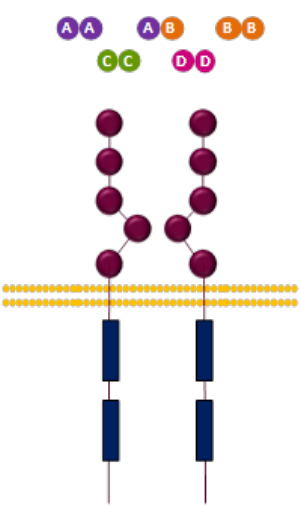
Figure 2. Structure of PDGFR and